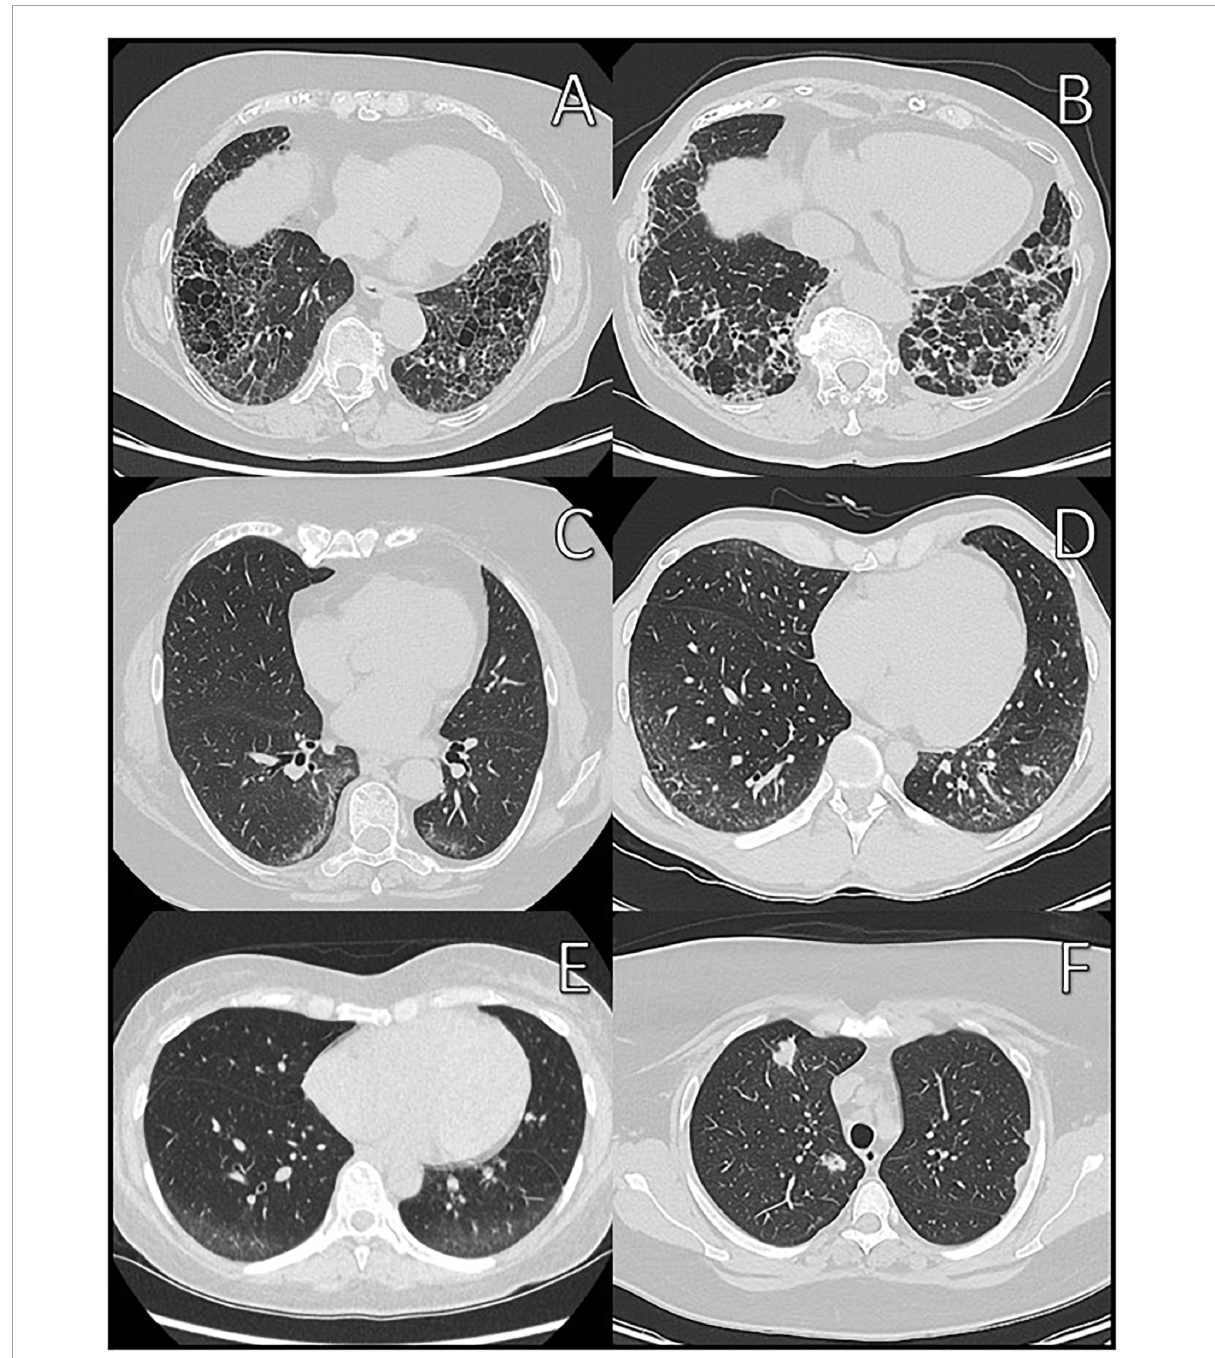
FIGURE2 Different CT-patterns in patient with IRD at initial diagnosis. (A) Usual interstitial pneumonia (UIP) in polymyositis; (B) probable UIP in systemic sclerosis; (C,D) non-specific interstitial pneumonia (NSIP) in Sharp syndrome; (E) pure ground-glass opacities in Sharp syndrome; and (F) granuloma/proliferations in granulomatosis with